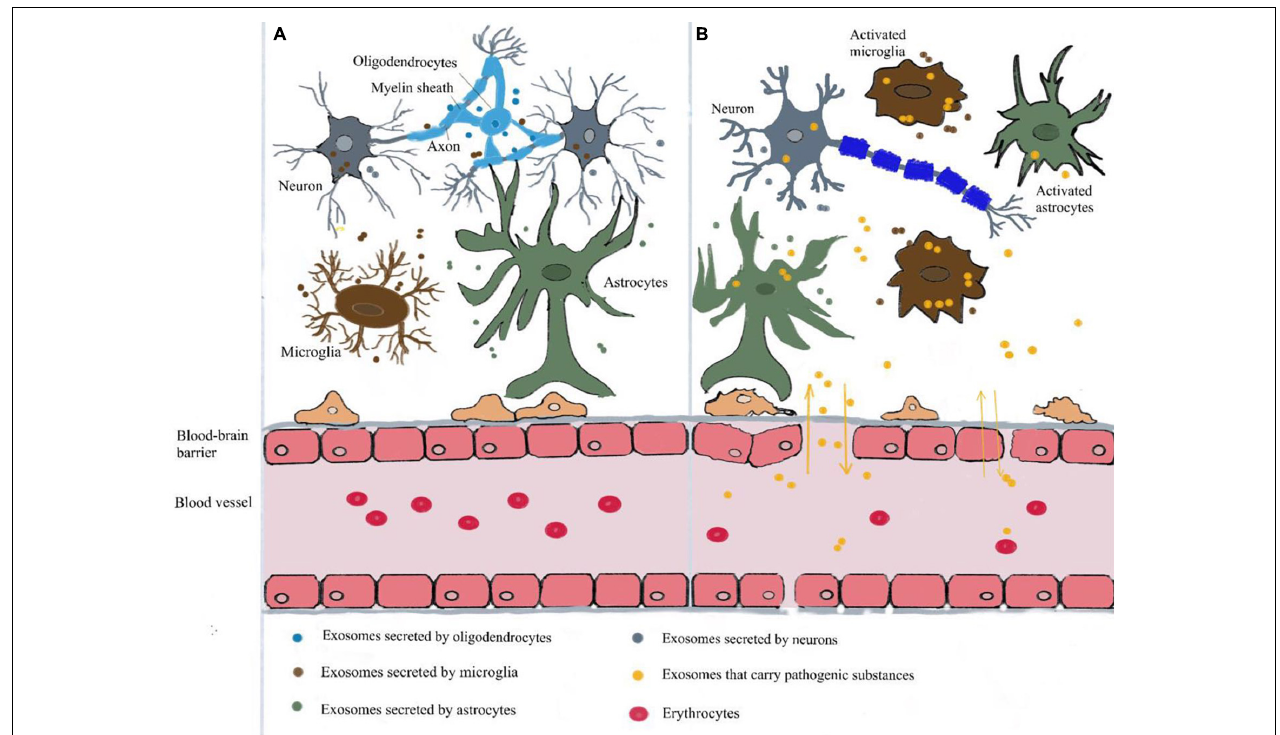
FIGURE 2 | Roles of exosomes in the healthy brain and a neuroinflammatory state of AD. (A) Healthy brain. Exosomes mediate normal intercellular communication in the brain. Glial-derived exosomes mediate important functions participating in neural circuit development and maintenance, promoting neurite outgrowth, synaptic activity and neuronal survival. Oligodendrocytes-derived exosomes provide trophic support to axons facilitating myelination. (B) Neuroinflammatory state of AD. In Alzheimer’s disease (AD), as an inflammatory mediator, exosomes induce neuroinflammation through information exchange between neurons and glial cells. They can diffuse in interconnected neurons and transport amyloid-beta (A β ) and tau proteins through the endosomatic pathway and axonal transport. At the same time, exosomes can cause neurological dysfunction by carrying pathogenic substances such as malregulated miRNA, mRNA and proteins. These exosomes are able to cross the blood-brain barrier propagating the neuroinflammatory response to the periphery. Similarly, plasma exosomes can also enter the brain and target neurons and glial cells, causing a series of pathophysiological